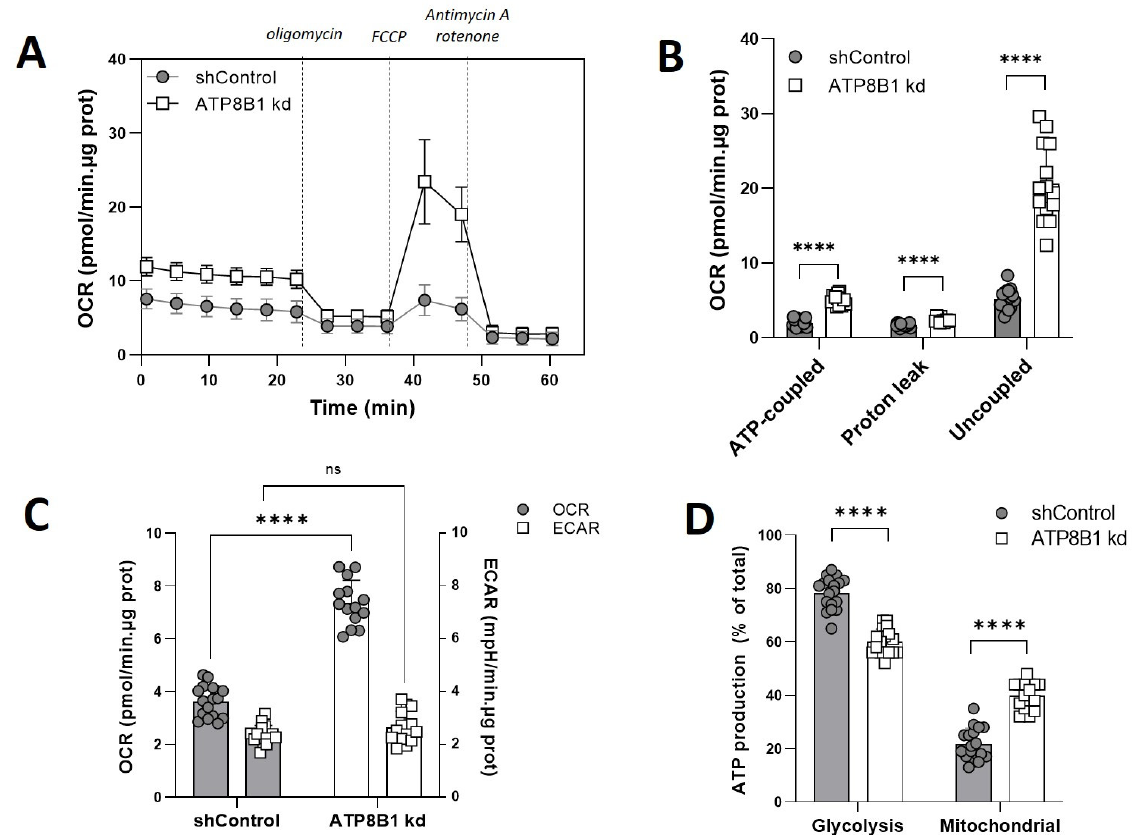
Figure 2. ATP8B1 knockdown coincides with increased mitochondrial OXPHOS. ( A ) Cells were incubated with 5.5 mM glucose and the oxygen consumption rate (OCR) was measured in a